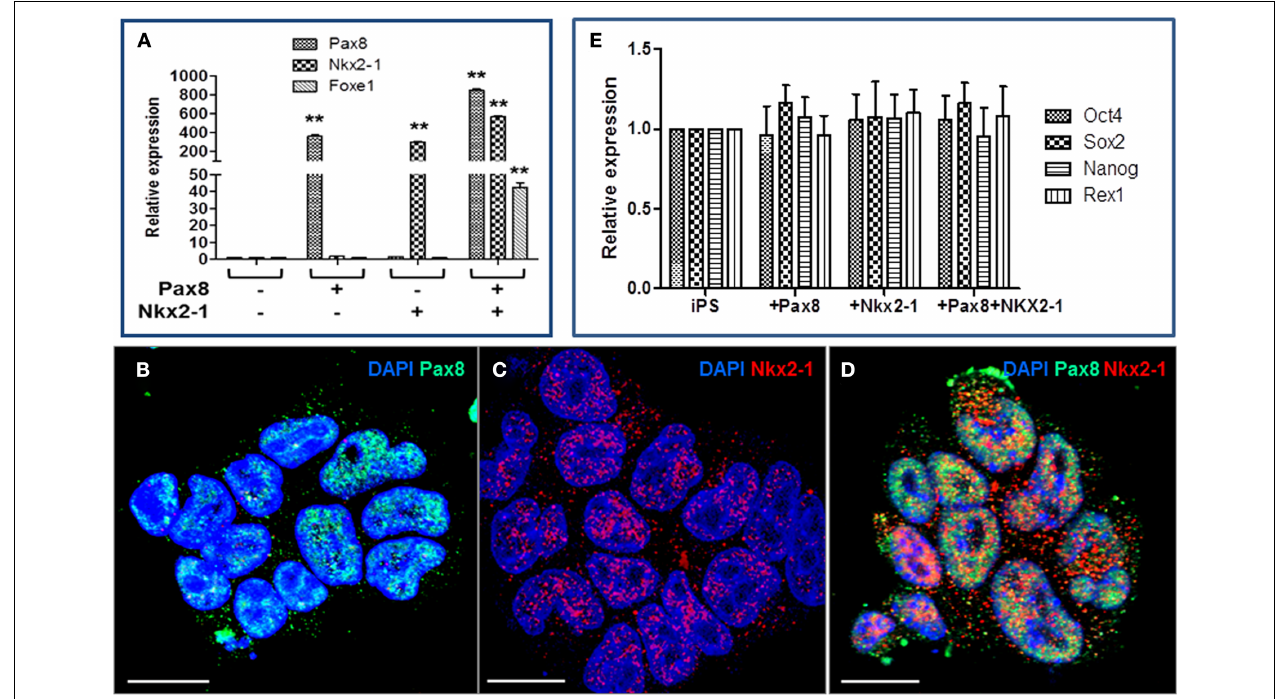
sets were analyzed in triplicate. ** p < 0.01 compared to untransfected iPS cells. (B–D) Immunofluorescence analysis of PAX8 and NKX2-1 in the transfected cell lines. Scale = 100 µ m. (E) Retention of stemness in transfected cell lines is shown by the continued expression of Oct4, Sox2, Nanog, and Rex1 gene expression.